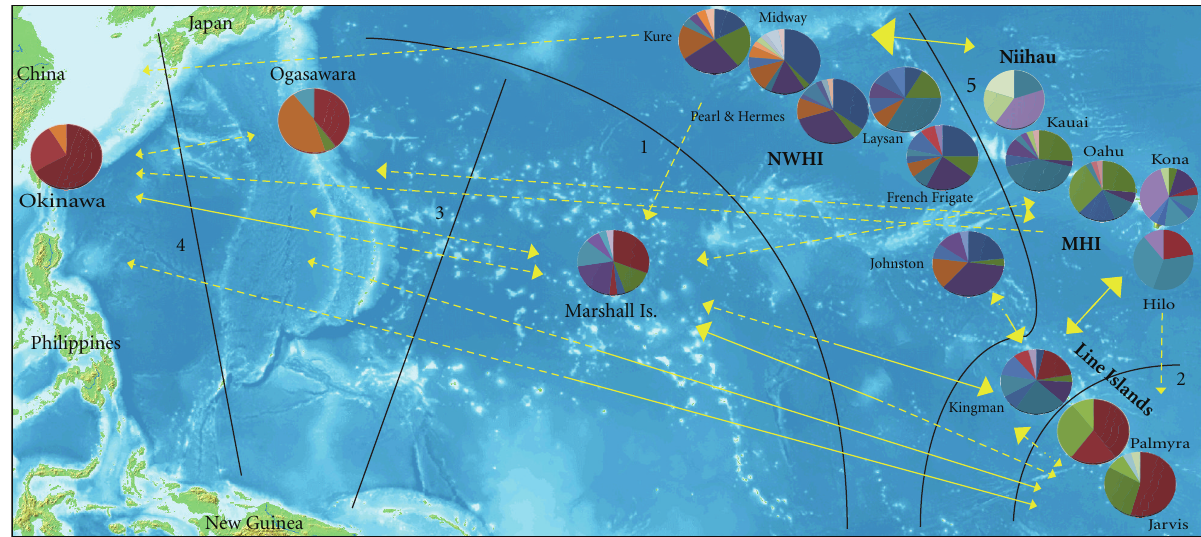
Figure 1: Map of the northern Central and West Pacific. Pie charts represent haplotype frequencies overlaid on sites. To avoid overlap, the Marshall Islands sites, Kwajalein and Majuro, have been combined. Black lines are major gene flow constraints drawn by BARRIER, numbered from strongest to weakest. Yellow arrows represent directional migration rates estimated by MIGRATE. E ff ective migration rate estimates ( N e M ) with modes between 0.01 and 0.49 are represented by small arrows, rates between 0.5 and 0.99 are represented by medium arrows, and rates over 1.0 are represented by large arrows. Solid lines represent migrate posterior probability distributions, where the 50% credibility set does not include zero. Dashed lines represent migration posterior probability distributions, where the 50% credibility set includes zero, but the distribution peak is greater than zero. Migration parameters with a posterior distribution peak of zero are not